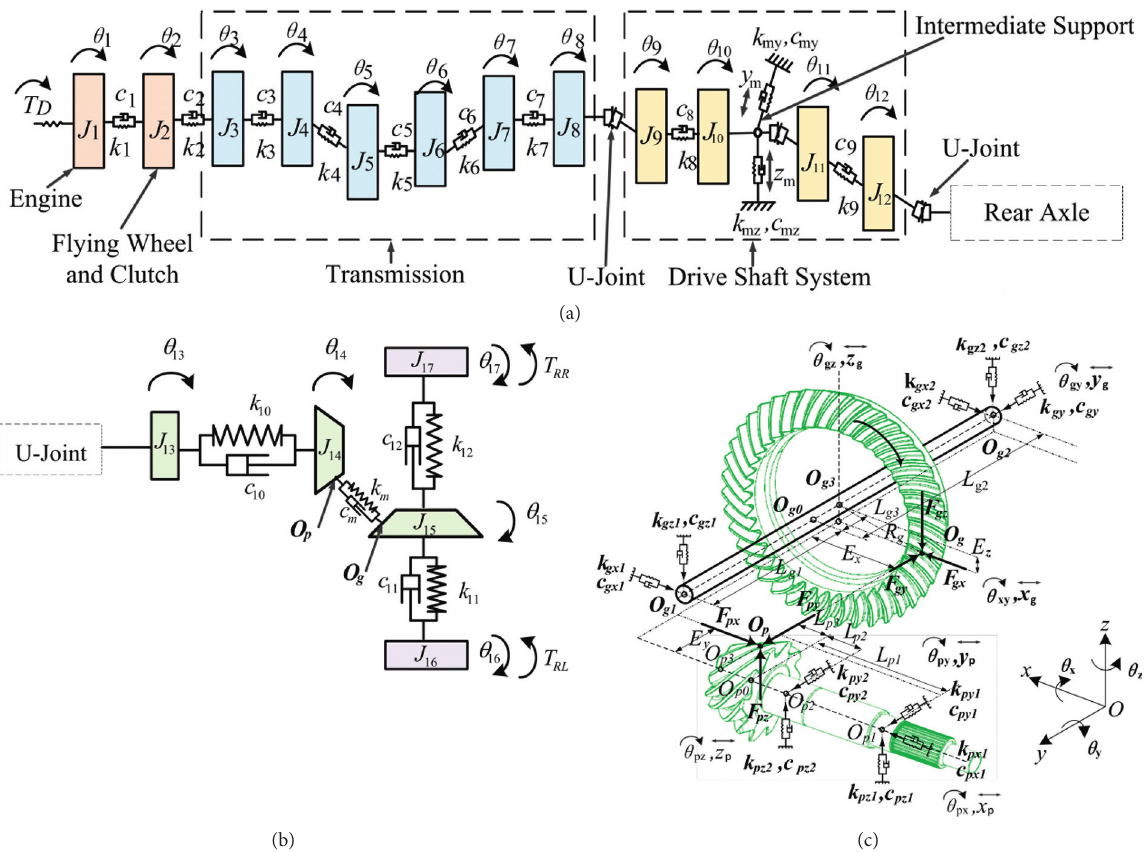
Figure 2: The dynamic model of the powertrain shown in Figure 1: (a) dynamic model of powertrain without rear axle; (b) torsional model of rear axle; (c) dynamic model of the main reducer in rear